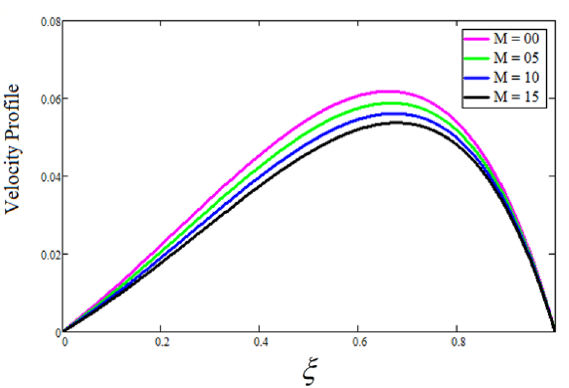
Figure 5. The consequence of M on velocity of fluid. Where R ζ = 2, φ = 0.04, δ = γ = π 3 , k = 0.3, Gr = 10, Gm = 20, β = 0.2, α = 0.5, t = 1, Sc =